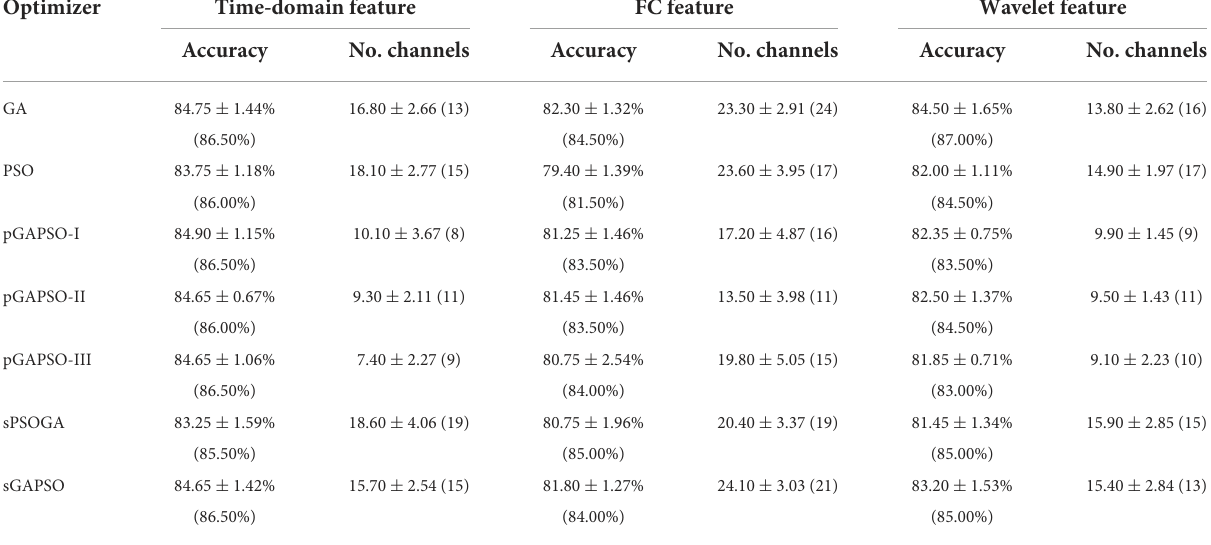
TABLE 1 Accuracy and the number of channels of different features and optimizers by 10-fold cross-validation, with the best results in the parathesis.